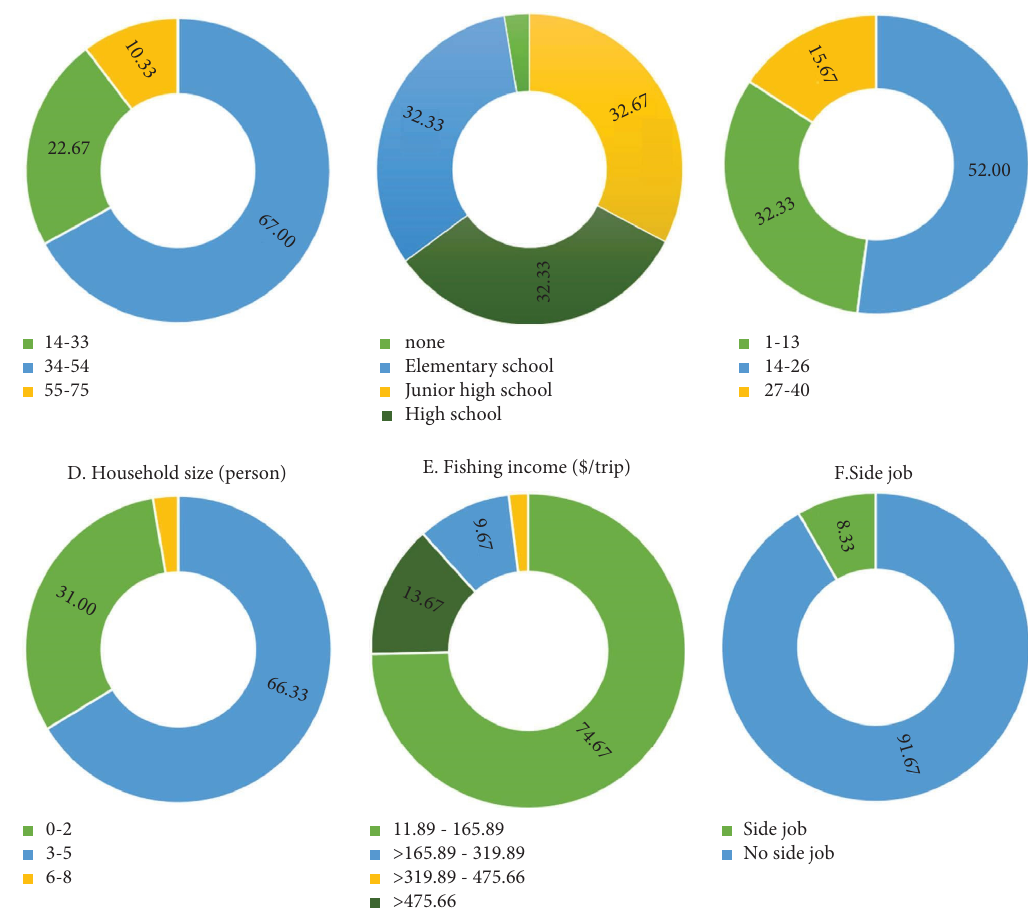
Figure 5: Percentage of the respondents based on sociodemographic characteristics (source: feld survey, 2021): (a) age (years), (b) education (years), (c) experience (years), (d) household size (person), (e) fshing income ($/trip), and (f) side